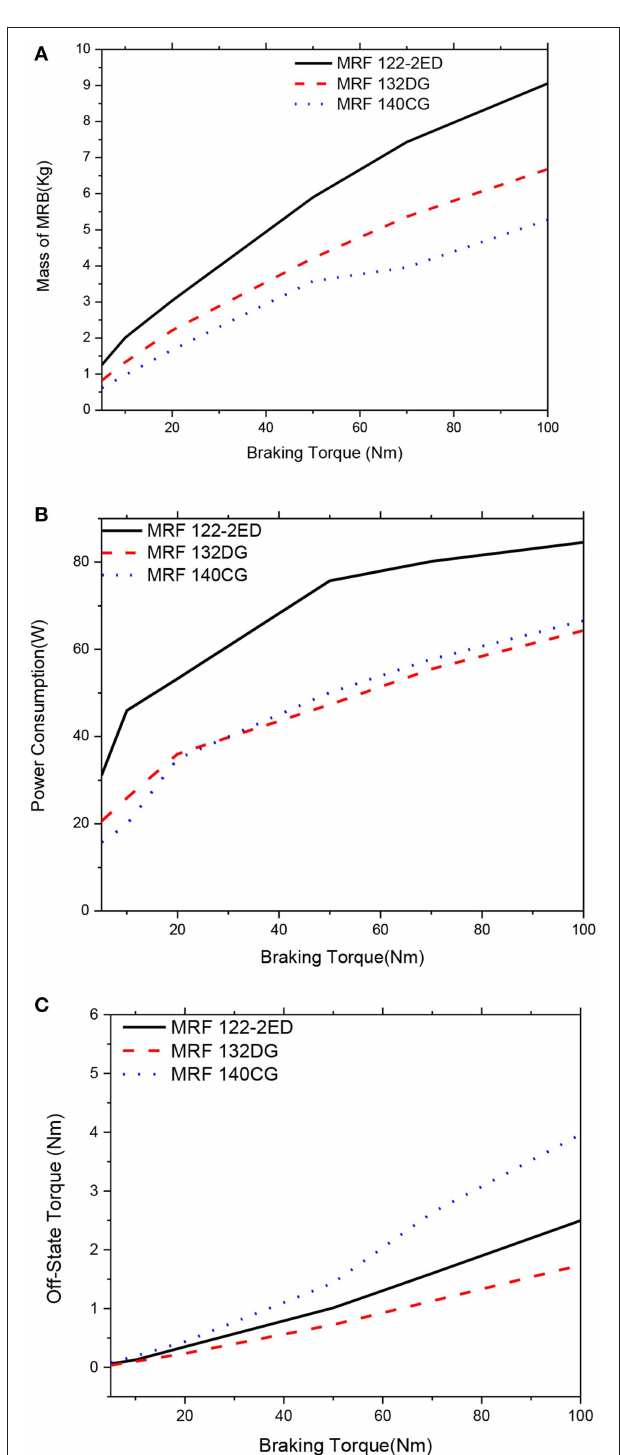
FIGURE 16 | Multi-objective optimization results of the MRBs as a function of braking torque of conventional MRB, α m = 0.5 ; α P = 0.0 ; α To = 0.5. (A) Mass as a function of braking torque, (B) Power consumption as a function of braking torque, (C) Off-state torque as a function of braking torque.